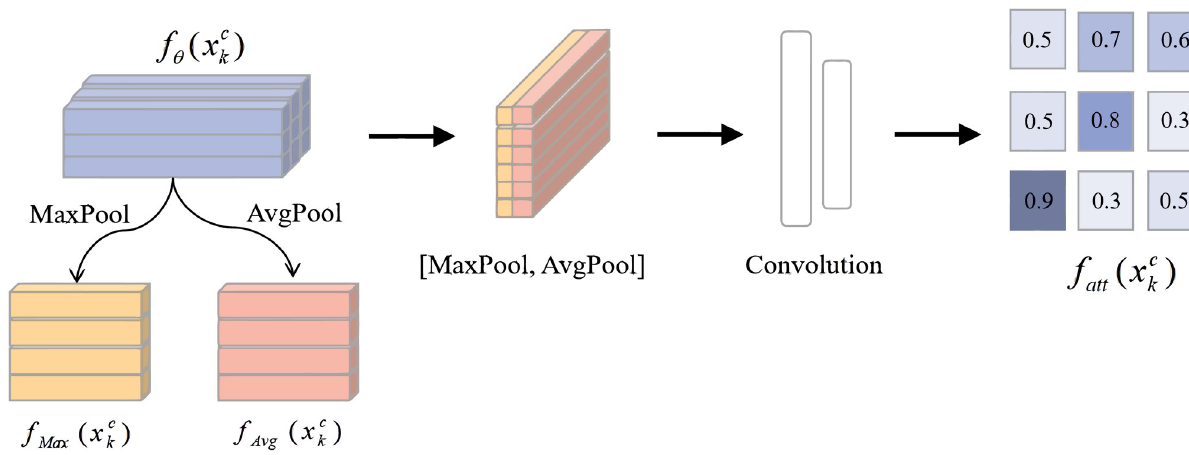
Fig 8. The process of spatial